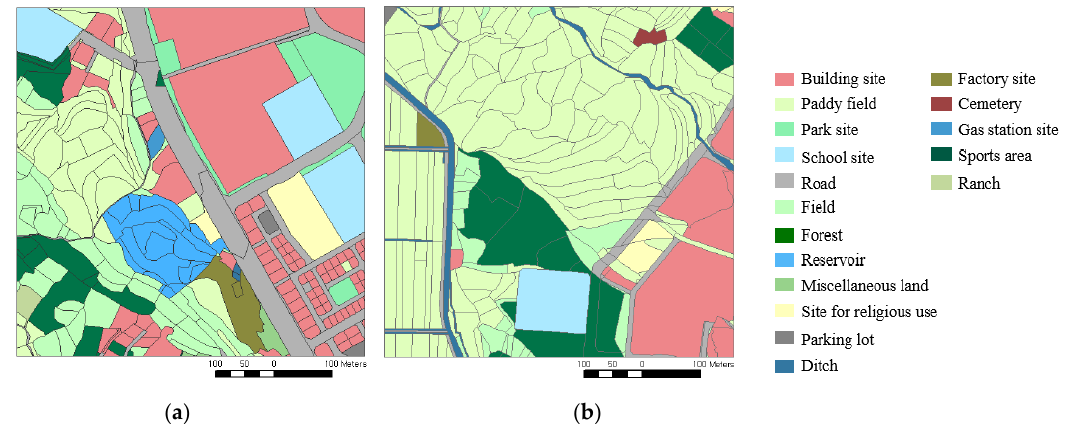
Figure 6. Cadastral map of the study sites in South Korea: ( a ) Site 1, ( b ) Site 2.